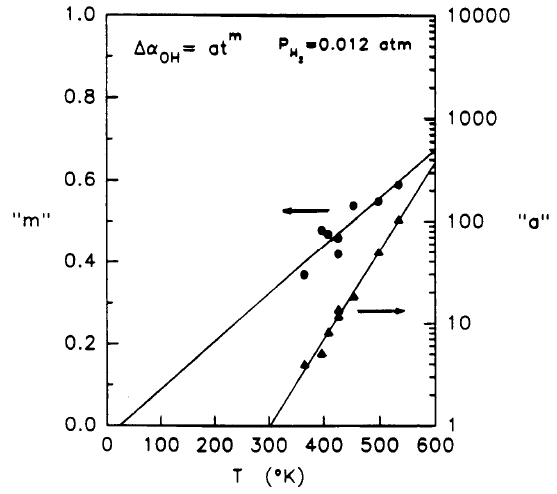
Figure 5. a and m coefficients deduced from non-linear data fitting